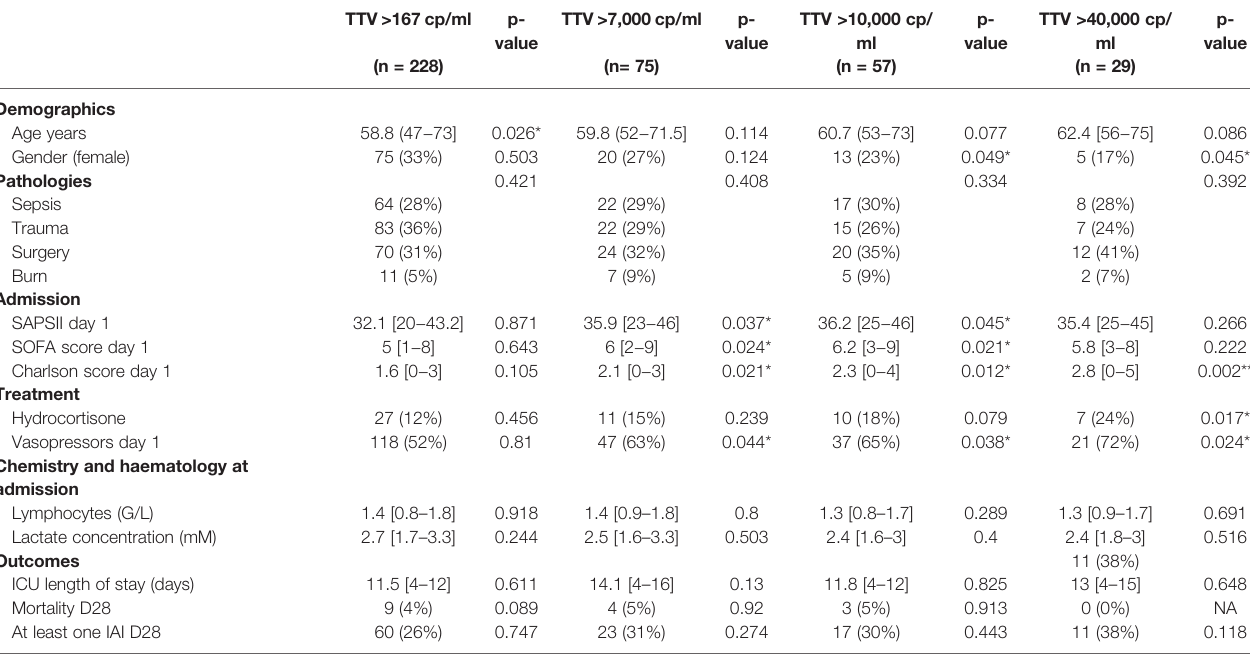
TABLE 2 | ICU patient characteristics at admission and outcomes according to TTV plasma DNAemia above 167 copies/ml (LOD), 7,000, 10,000, and 40,000 copies/ ml, during the fi rst month (D1 – D28) in ICU. TTV >167